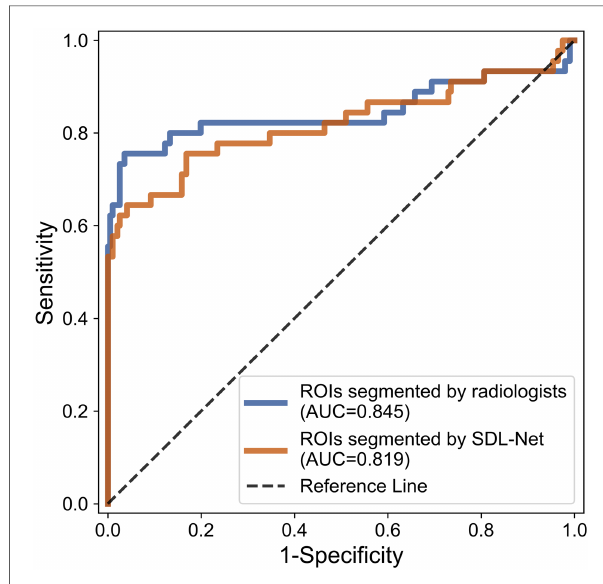
FIGURE 8 ROC curves for WMI status prediction based on different ROIs in the testing